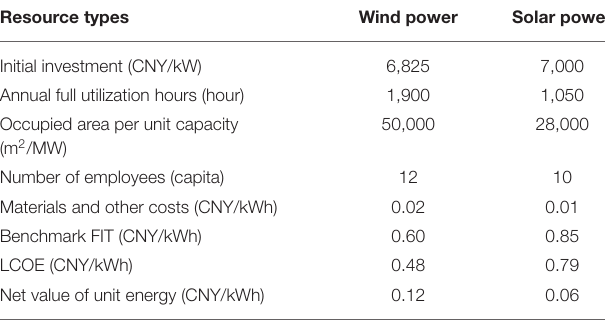
TABLE 1 | Parameters setting and LCOEs for wind and solar power